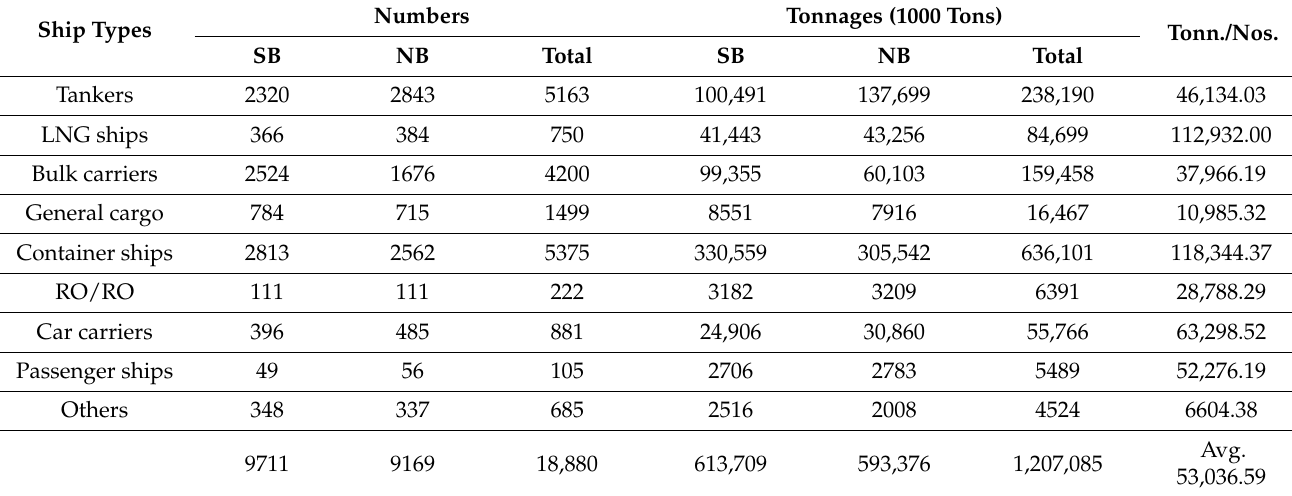
Table 7. Numbers and tonnages of southbound (SB) and northbound (NB) ships passing through the New Suez Canal in